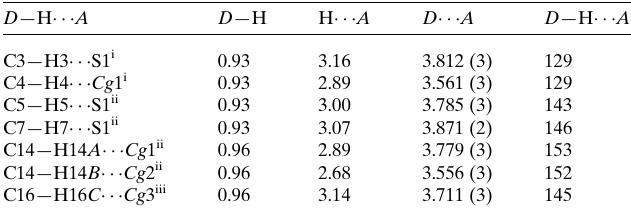
Table 1 Hydrogen-bond geometry (A˚ , (cid:3) ) for ( I ). Cg 1 is the mid-point of the C1 N1 group. Cg 2 and Cg 3 are the centroids of the N2/C2–C6 and C8–C13 rings.